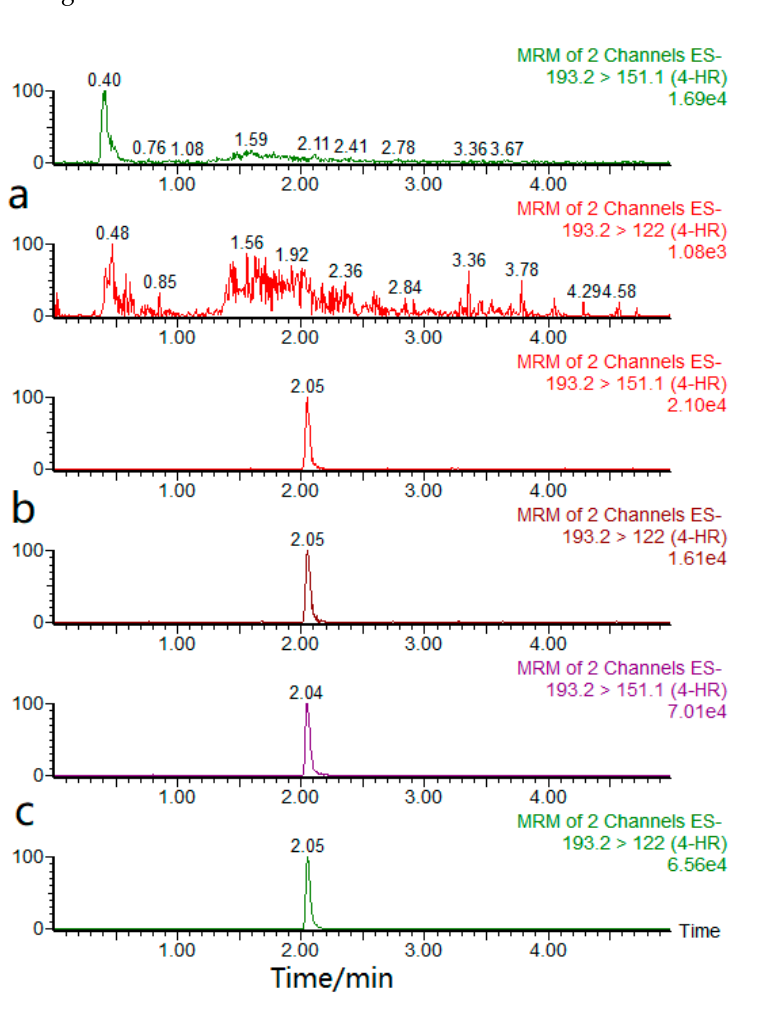
Figure 2. MRM chromatograms of 4-HR ( a ) blank sample, ( b ) shrimp spiked sample and ( c ) standard solution.